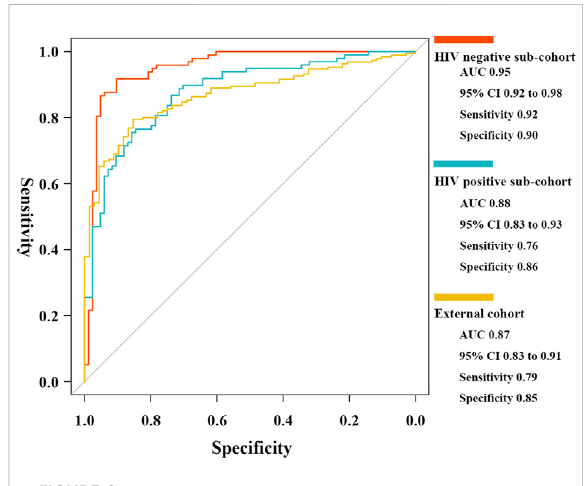
FIGURE 8 ROC curves of the elastic net diagnostic classi fi er in HIV- negative/positive sub-cohorts and the external